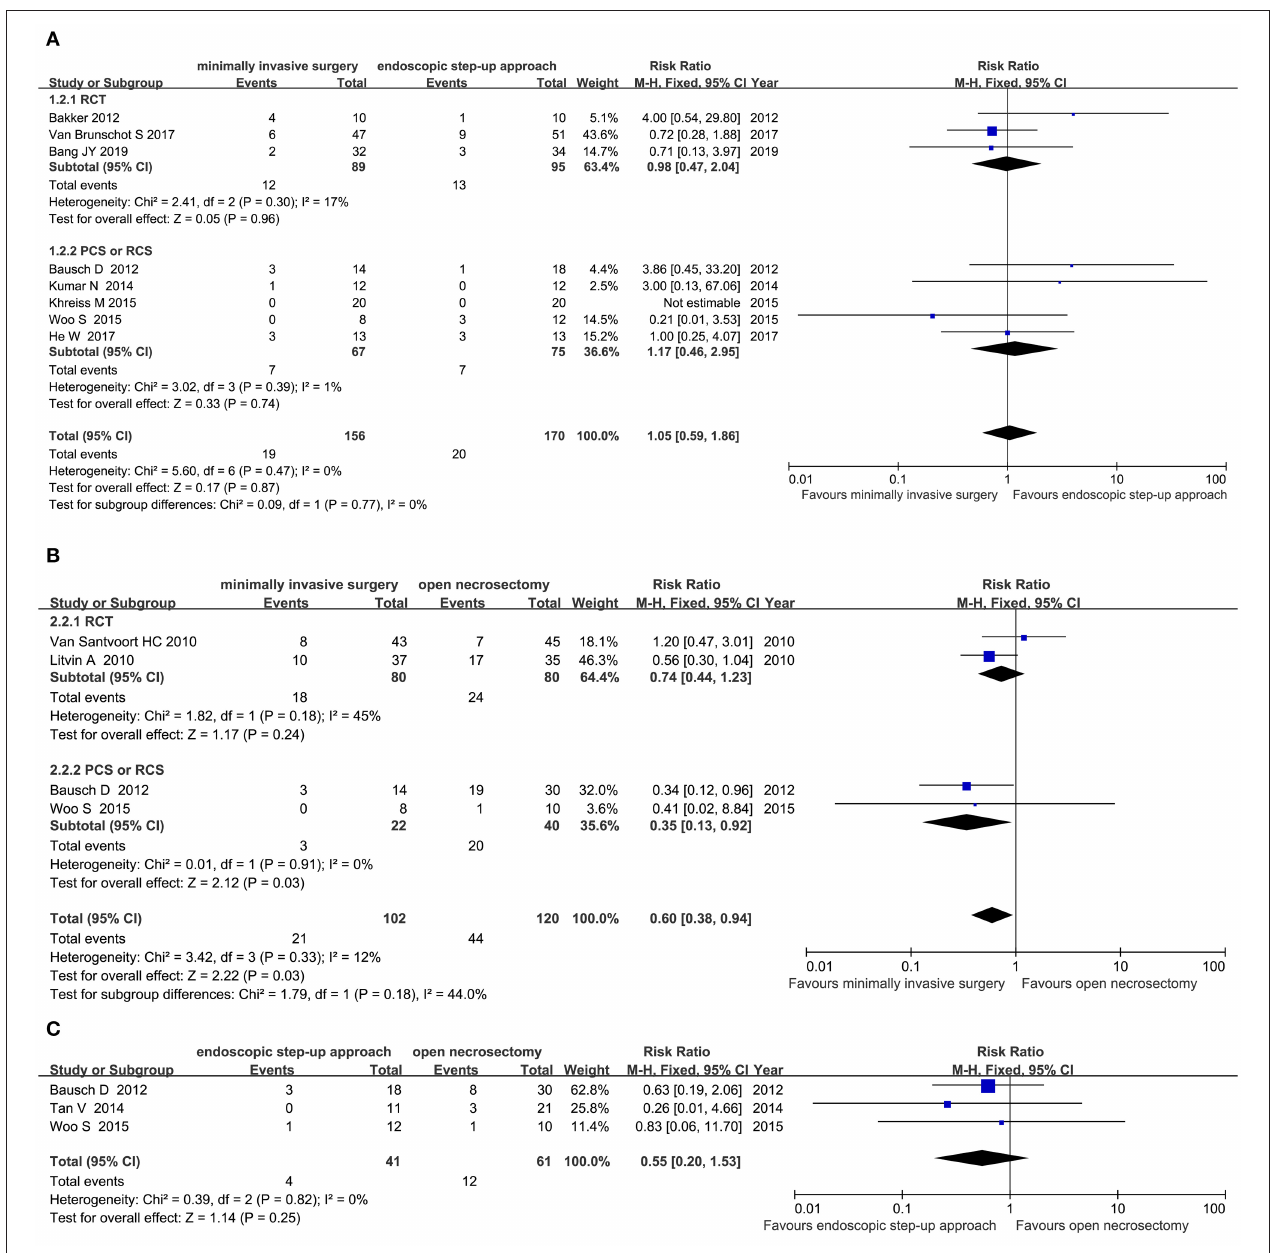
FIGURE 4 | Forest plots for the mortality. (A) Between minimally invasive surgery and endoscopic step-up approach. (B) Between minimally invasive surgery and open necrosectomy. (C) Between endoscopic step-up approach and open necrosectomy. M-H, Mantel–Haenszel test; Fixed, a fixed effects model; CI, confidence intervals.